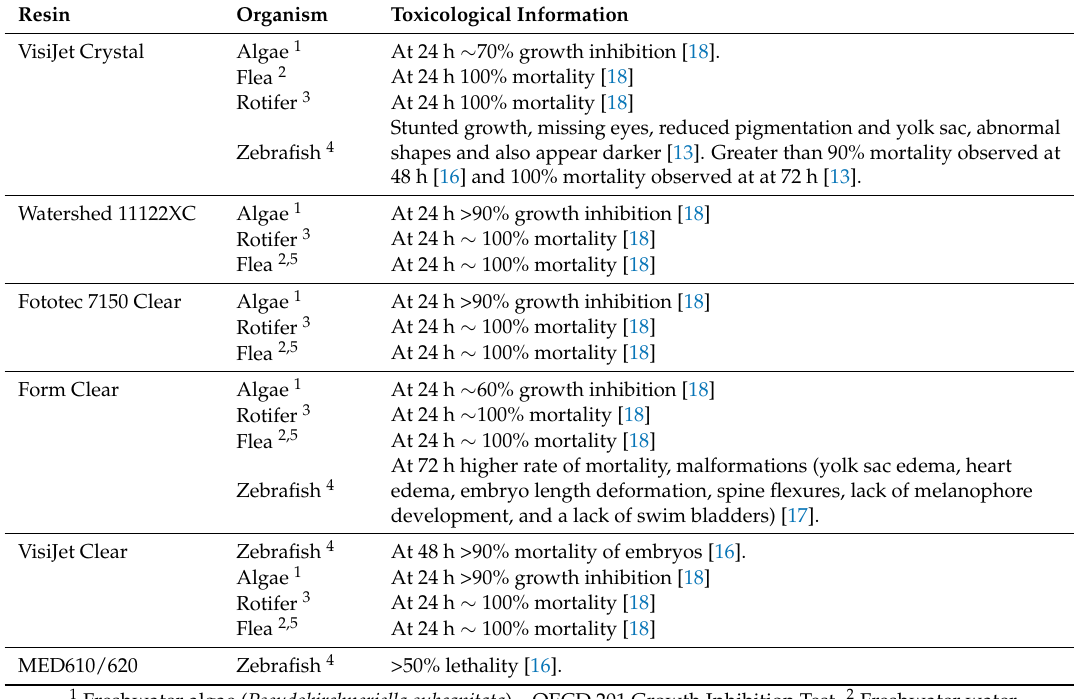
Table 4. Summary of recent assessments on biocompatibility of parts printed with commercially available SLA and MJ printing